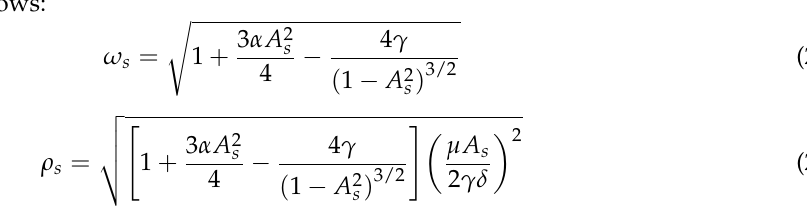
; solid line: stable solutions;